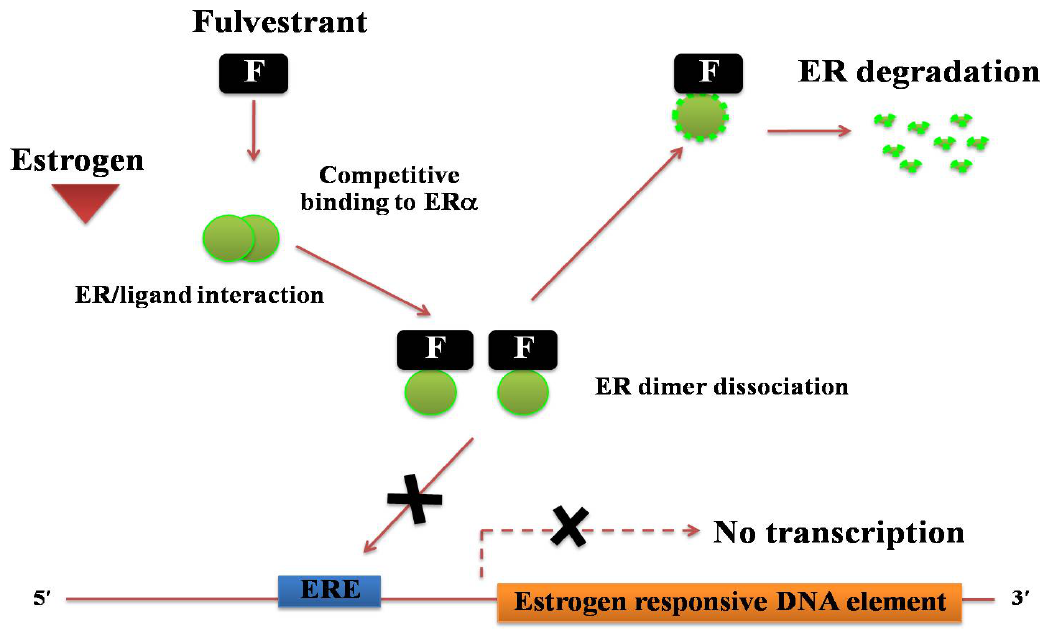
Figure 6. The molecular mechanism for the pure steroidal ER α antagonist, fulvestrant. Fulvestrant binds competitively to ER α with a high affinity. It acts as an antiestrogen chemical by reducing the half-life of ER α , resulting in a decrease in expression of ER α . Formation of the drug-receptor complex leads to stabilization of the receptor, which is degraded by an ubiquitin-proteasome